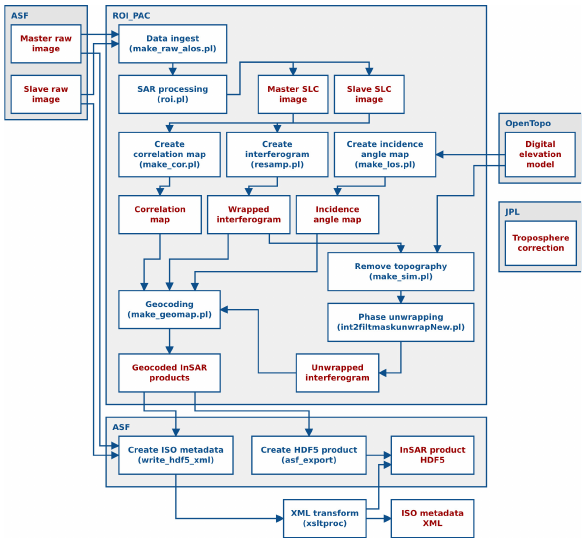
Figure 11. InSAR Processing Flow